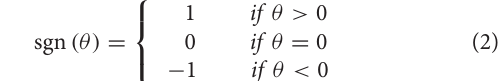
where A is the slope value. For time series Y t , T t